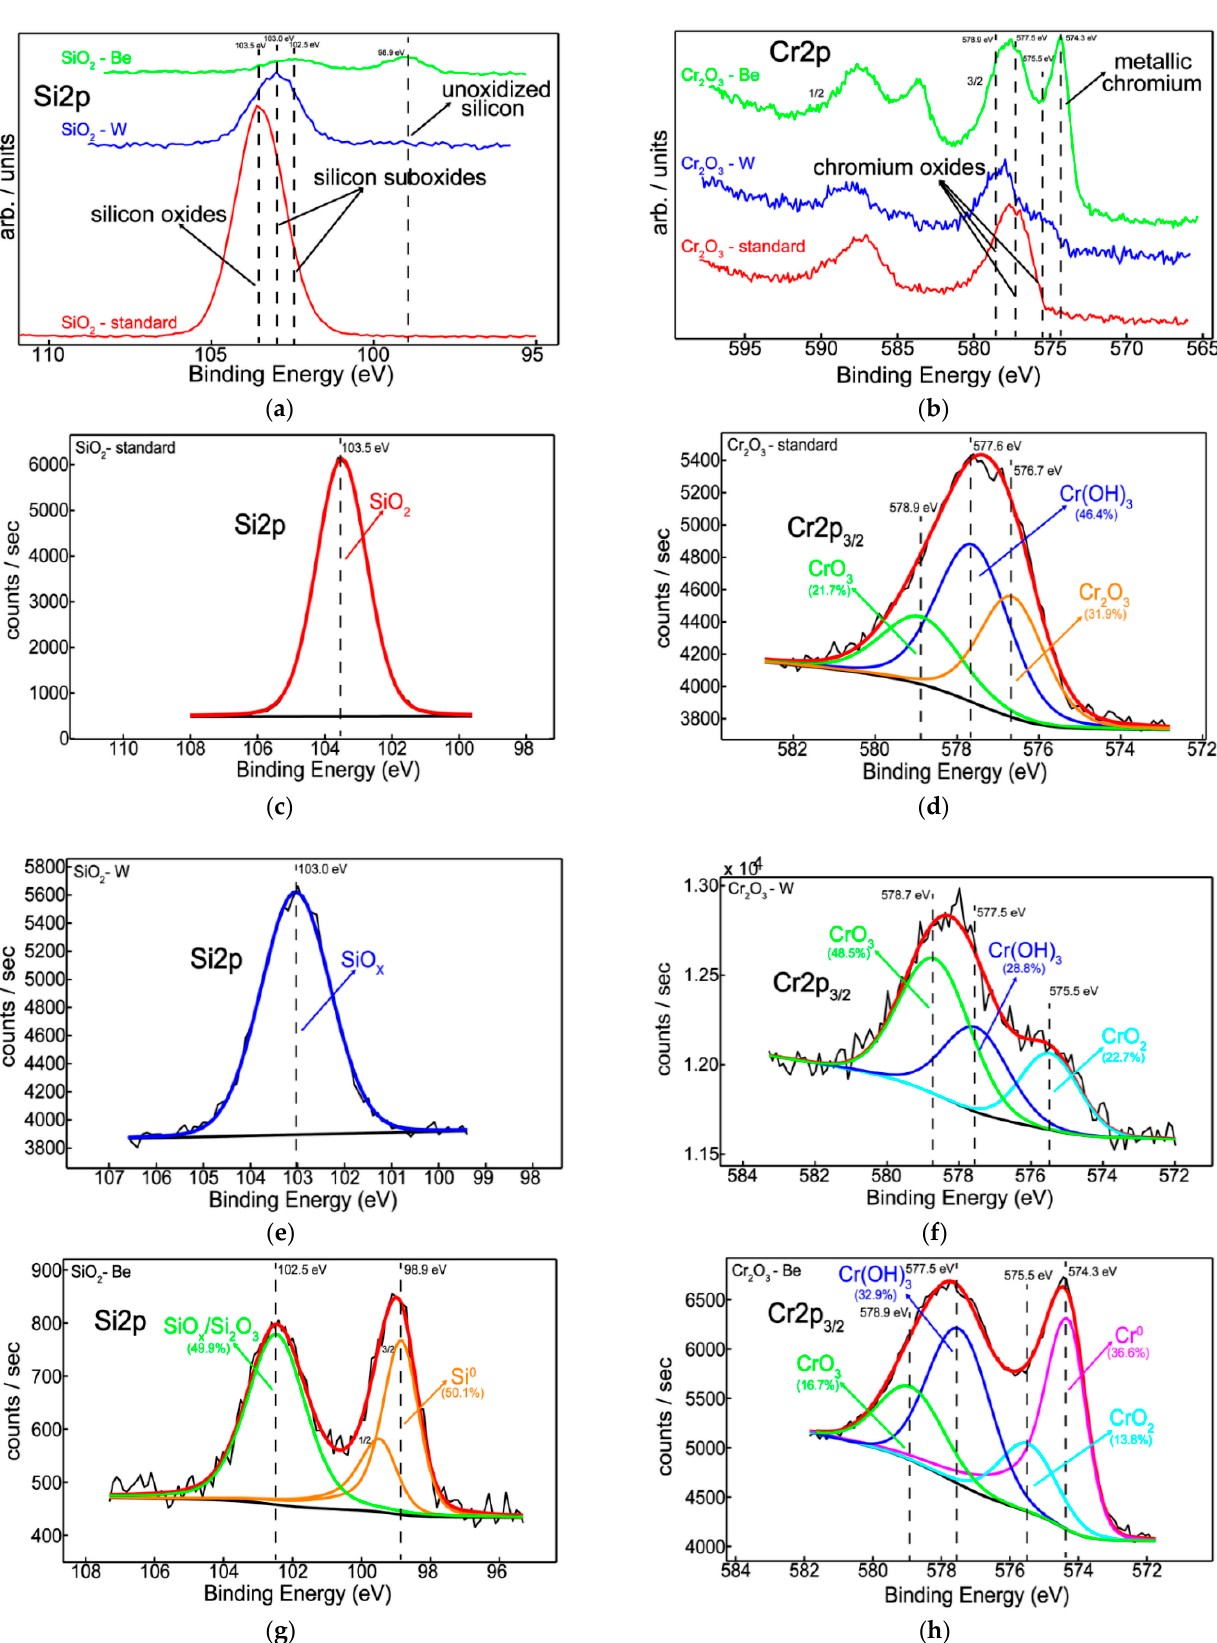
Figure 3. Superimposed XPS spectra for the three stages of Si ( a ) and Cr ( b ) systems; XPS peak-fitted spectra for the three stages of Si ( c )—B1, ( e )—B2, ( g )—B3 and Cr ( d )—A1, ( f )—A2, ( h )—A3 systems.